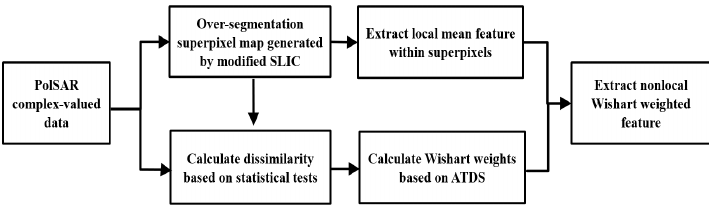
Figure 2. Scheme of the nonlocal Wishart weighted feature (NWWF)